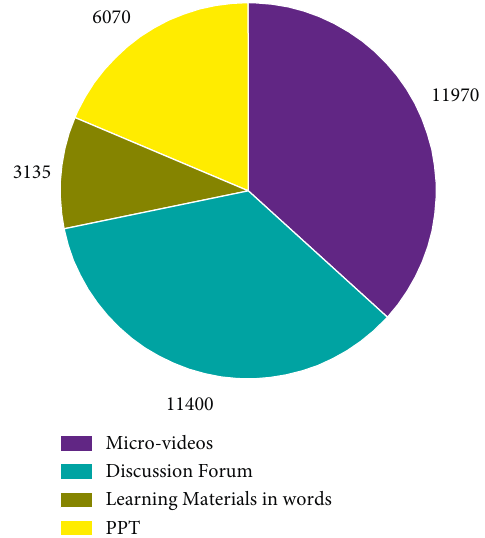
Figure 3: A total number of clicks on each learning resource per semester.